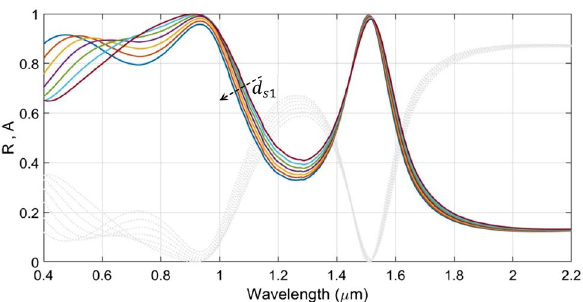
Figure 7. Plots of absorbance A (and reflectance R ) versus wavelength under fixed values of d GST1 (= 130 nm), d GST2 (= 70 nm), d s2 (= 120 nm), d s3 (= 60 nm) and varying d s1 . Coloured lines correspond to absorbance; gray dotted lines represent reflectance. The dashed arrow represents increase in d s1 .